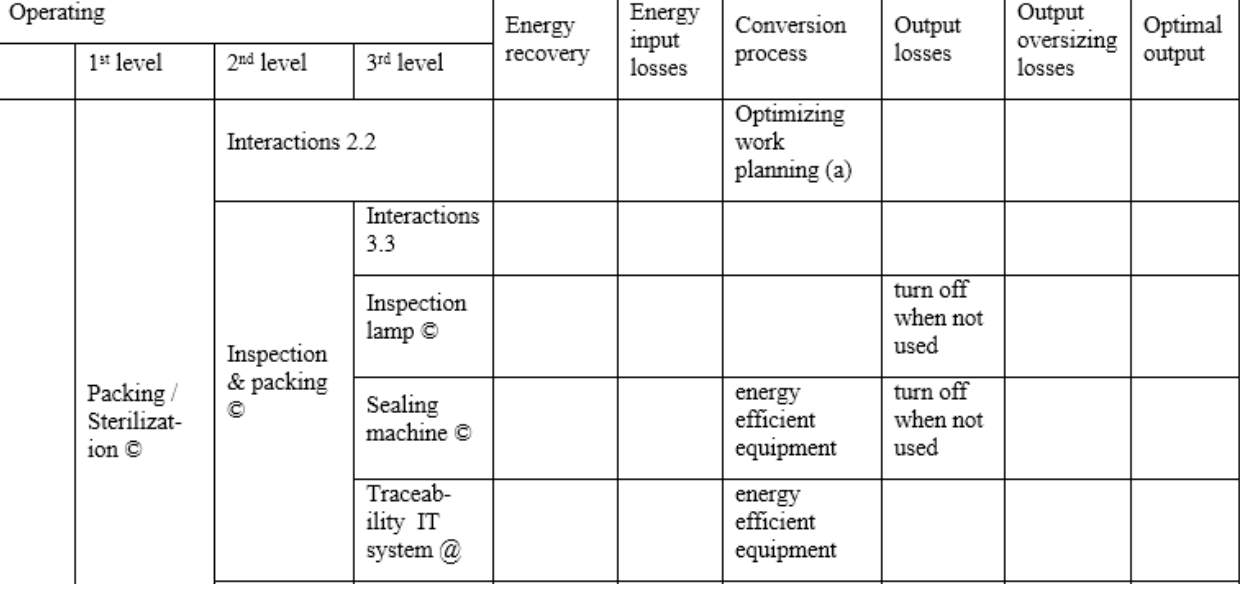
Figure 8. Matrix of proposed energy-saving measures- washing disinfection zone- CSSD- University